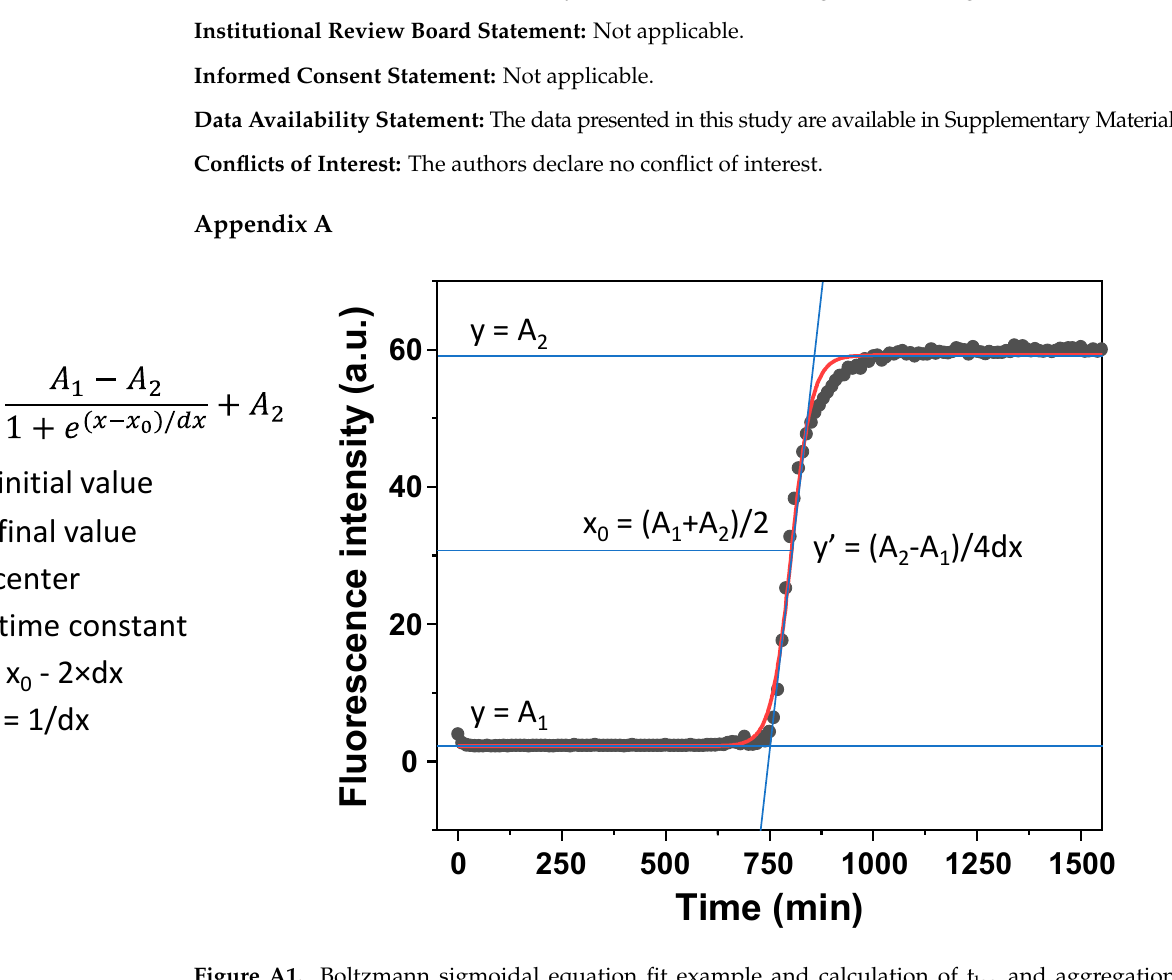
Figure A1. Boltzmann sigmoidal equation fit example and calculation of t lag and aggregation apparent rate constant. Sample fluorescence intensity is determined as the final value of the fit (A 2 ).